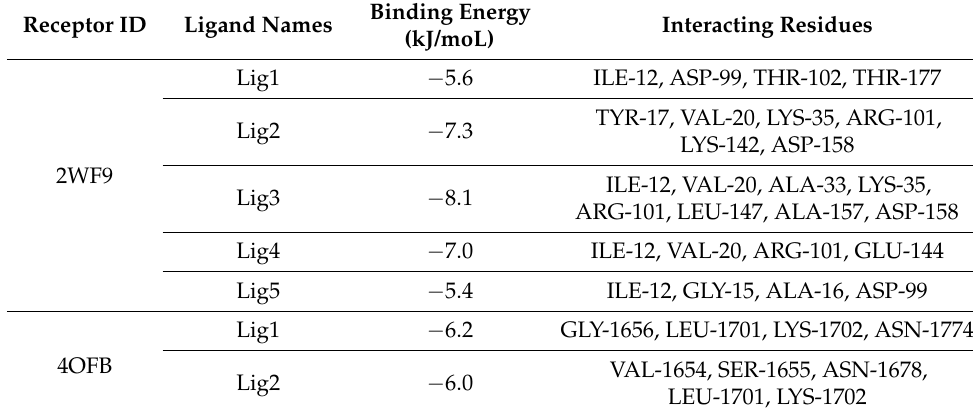
Figure 15. Molecular Docking Results of ( A ) lig1, ( B ) lig2, ( C ) lig3, ( D ) lig4 and ( E ) lig5 with CCND1 cancer receptor (2WF9). Table 1. Molecular Docking binding energy and interaction